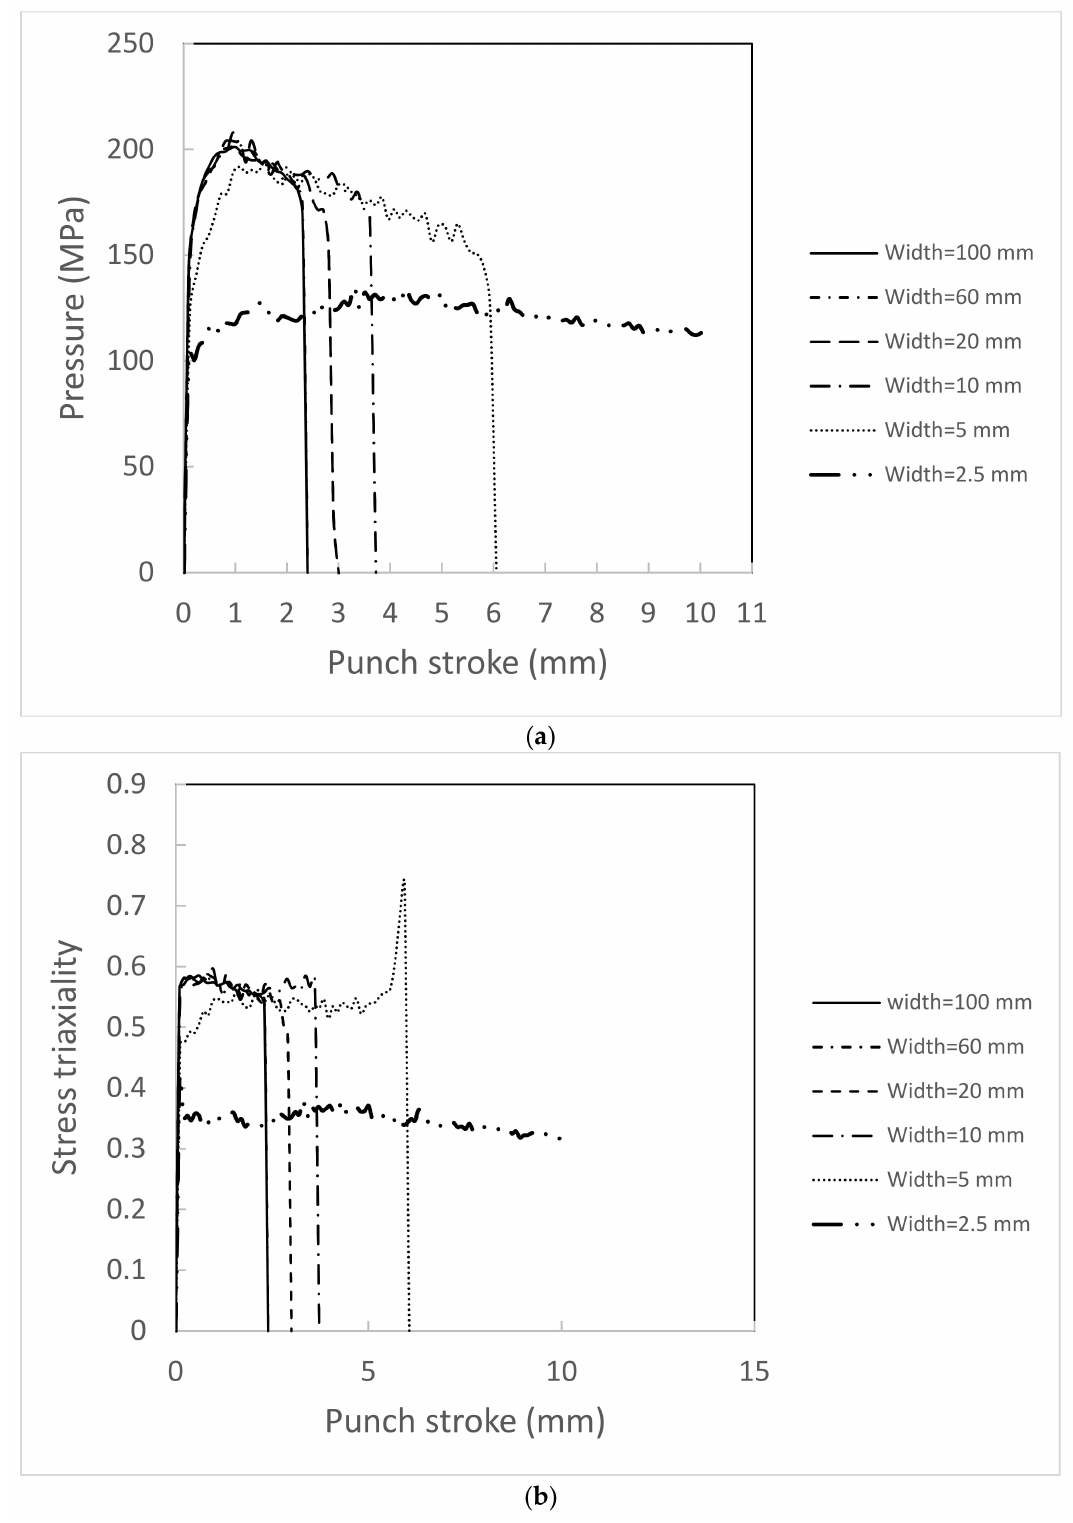
Figure 9. Effect of width on ( a ) hydrostatic pressure and ( b ) stress triaxiality at point